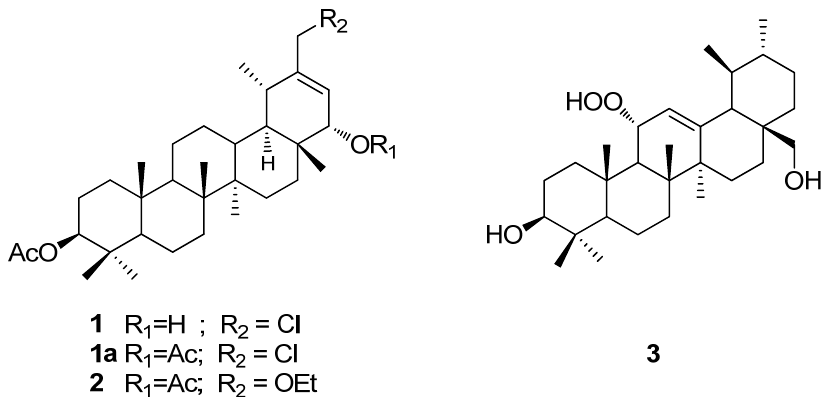
Figure 1. Compounds 1 – 3 isolated of the T. proustii and T. lagopoda